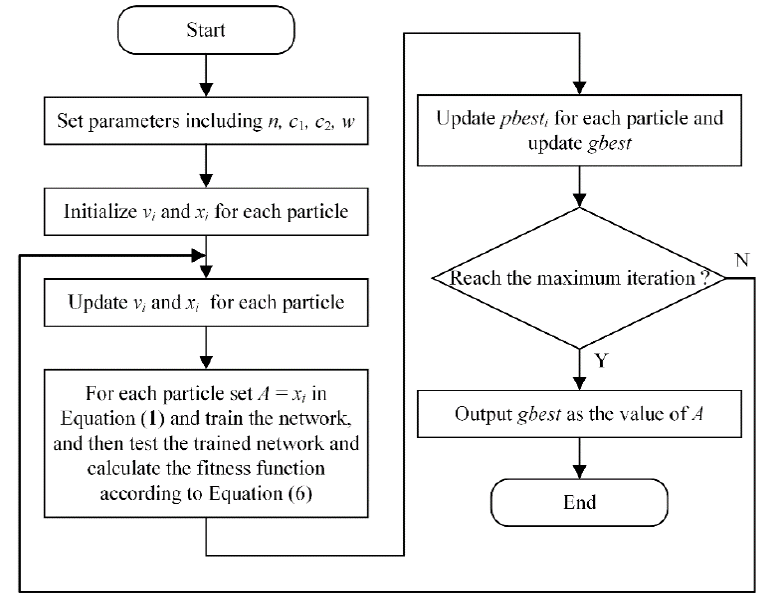
Figure 4. Flowchart of the particle swarm optimization (PSO) optimization.